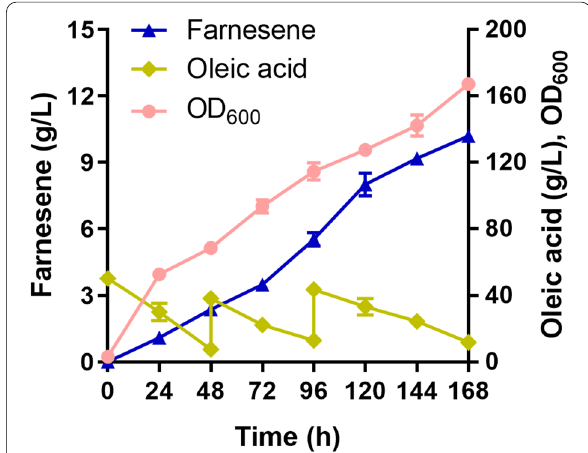
Fig. 6 α-Farnesene production, oleic acid consumption and growth of strain F10 in fed-batch cultivations. The cultivation was carried out in a 5-L bioreactor containing 4 L YP medium with oleic acid at pH 6.0, 1.5 vvm air flux, and 500 rpm stirring rate. Oleic acid was fed when it was lower than 10 g/L. The error bars represent standard deviations of duplicate